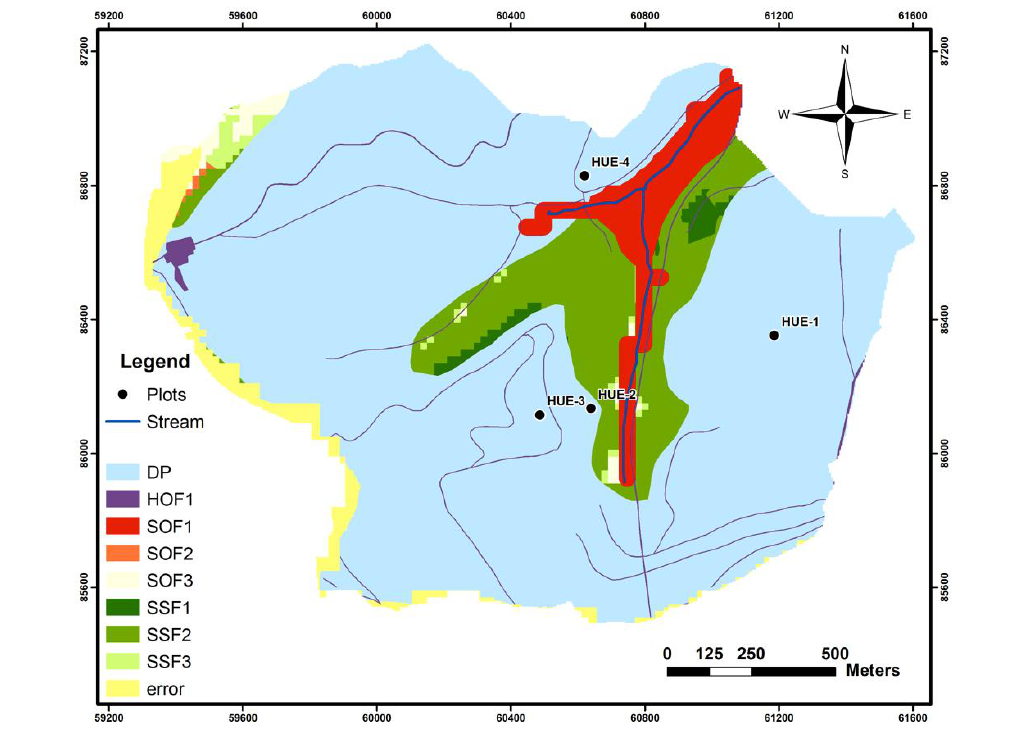
Figure 9. GIS-DRP map of the Huewelerbach catchment, Luxembourg (error = lack of basic